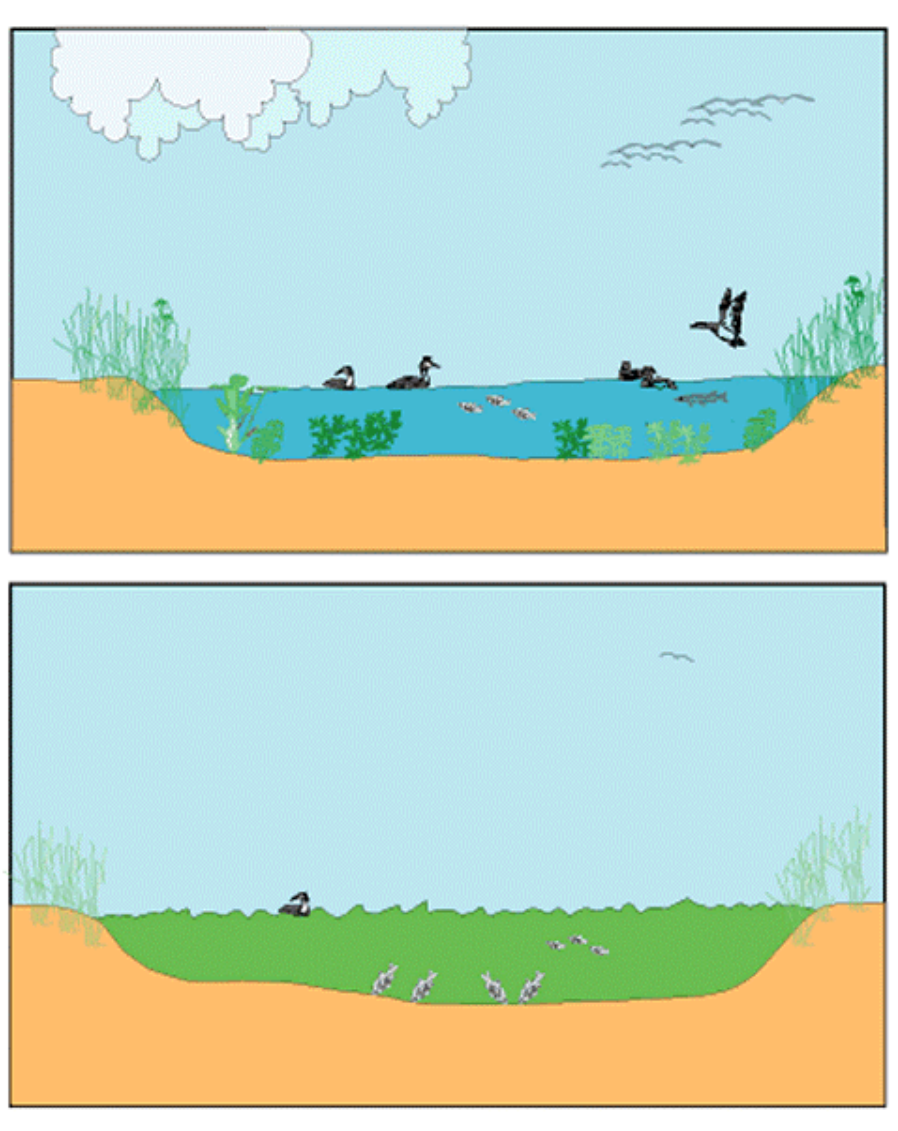
FIGURE 1. Schematic representation of a shallow lake in a vegetation-dominated clear state (upper panel) and in a turbid phytoplankton-dominated state in which submerged vegetation is largely absent and fish and waves stir up the